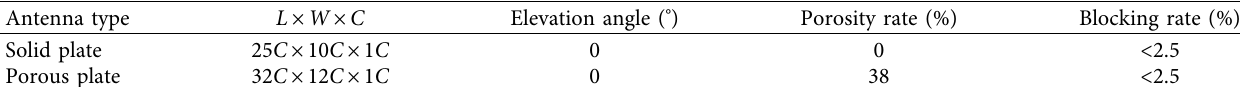
Table 1: Test model details.